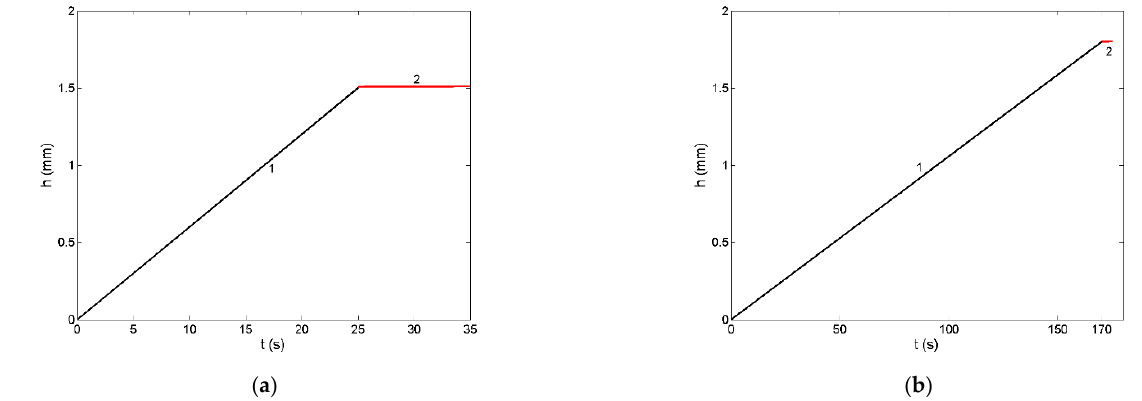
Figure 10. Infiltration curves for liquid IrSi 3 /SiC system for ( a ) short- and ( b ) long-term experiments performed at T = 1523 and T = 1623 K [12]: the reactive infiltration (curves 1) and “similar to non-reactive” infiltration (curves 2).